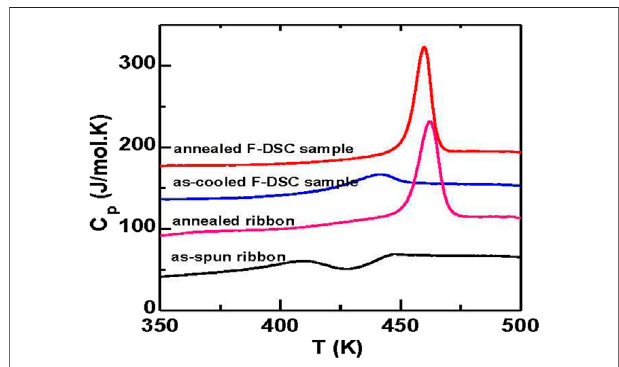
FIGURE 15 | DSC traces of the glass transition behavior of the as-spun ribbon, the ribbon annealed at 373 K for 105 s (annealed ribbon), the sample cooled in-situ at 6000 K/s using Flash DSC (as-cooled F-DSC sample), and the sample annealed in-situ at 373 K for 105 s (annealed F-DSC sample). The curves have been shifted vertically for comparison (from (Wang et al., 2016)).